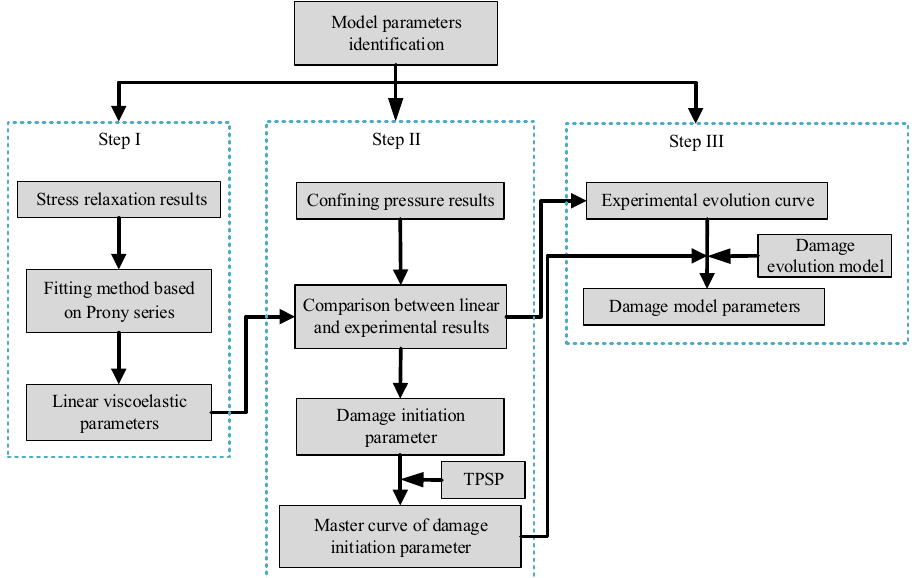
Figure 6. The flow chart of model parameters identification.